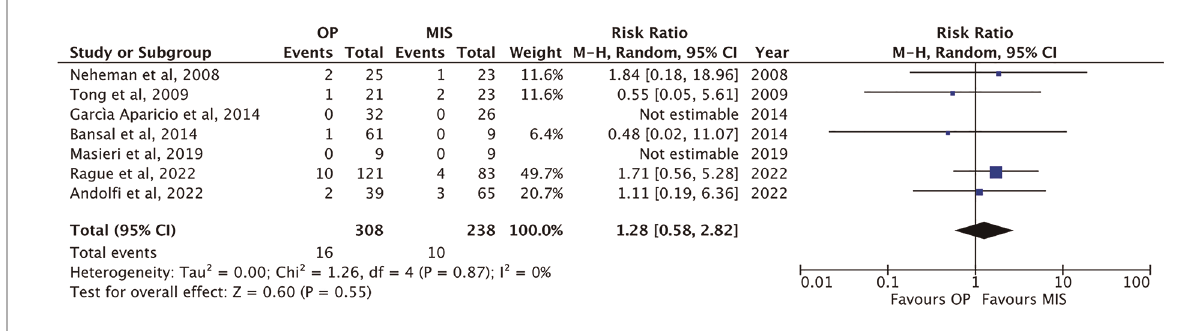
FIGURE 8 Forest plot comparison of the incidence of failure between OP and MIS in